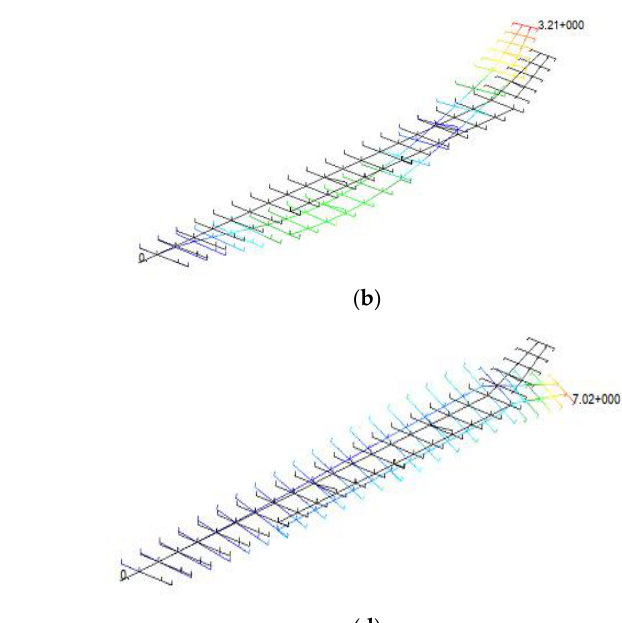
( d ) Figure 6. Fuselage component modal shape of first four elastic modes. ( a ) 1st order mode, symmetric. ( b ) 2nd order mode, symmetric. ( c ) 3rd order mode, asymmetric. ( d ) 4th order mode, asymmetric. Table 3. Wing component mode analysis results. Order